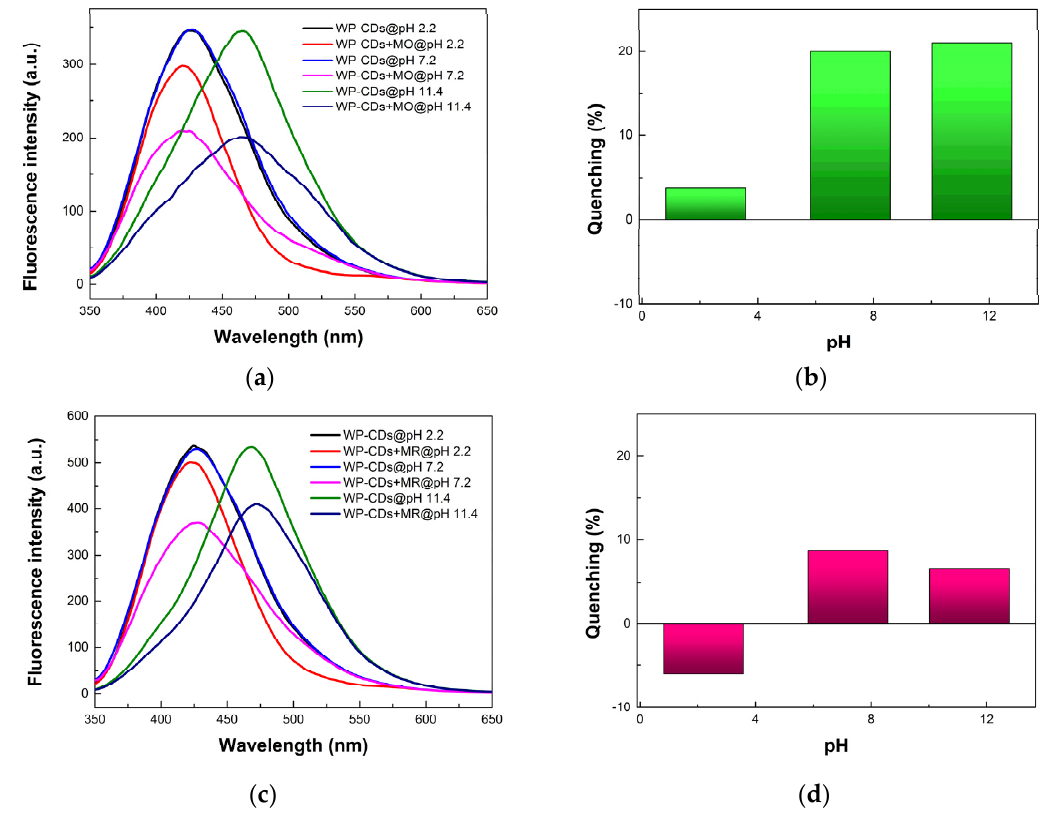
Figure 3. Quenching dependance on varying the pH (2.2, 7.2, and 11.4) of buffered solutions of WP-CDs (0.1 mg/mL) for 10 µ M of MO ( a ) and MR ( c ) and the corresponding quenching efficiencies ( b ) and ( d ). Excitation at 340 nm in acetate (pH = 2.2), phosphate (pH = 7.2), and glycine (pH = 11.4) buffers. All data corrected for IFEs at excitation (340 nm) and emission (426 nm at pH 2.2 and 7.2 and 468 nm at pH 11.4).